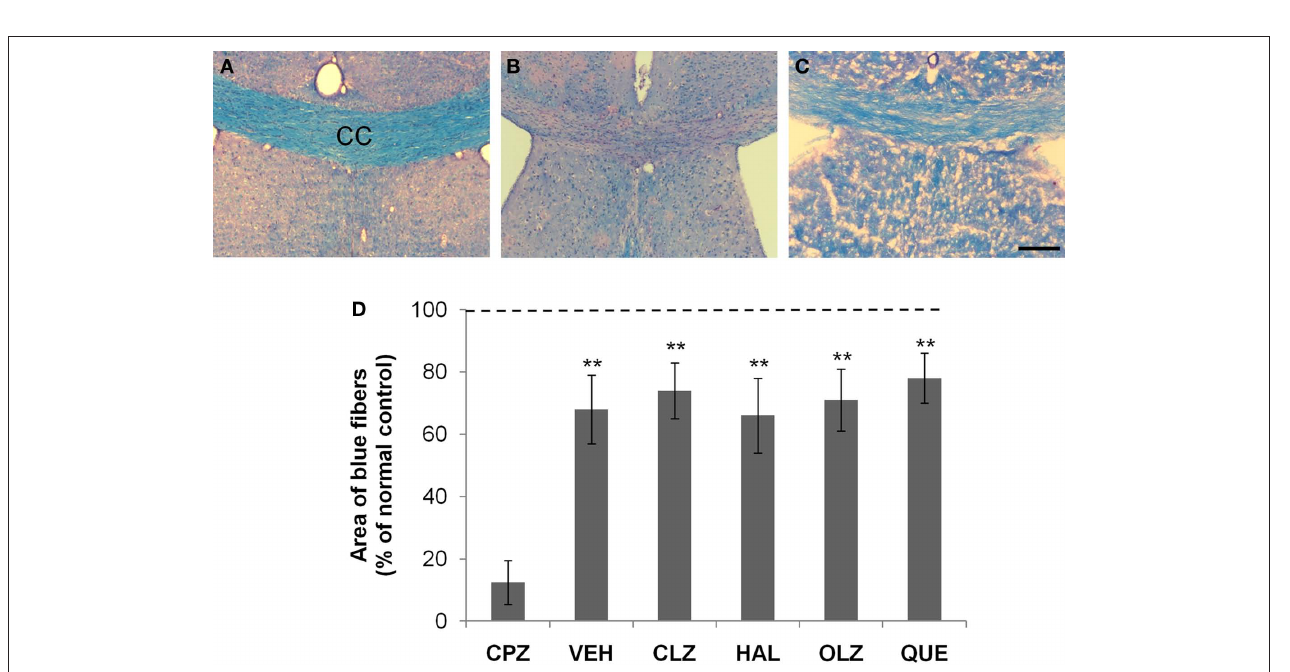
Figure 5 | incomplete remyelination of the corpus callosum (CC) after CPZ withdrawal. (A) An image from an animal of the control (CNT) group showing normal myelinated fibers (in blue) in CC. (B) An image from a mouse exposed to CPZ for 5 weeks showing no normal myelinated fibers in CC. (C) An image from a mouse